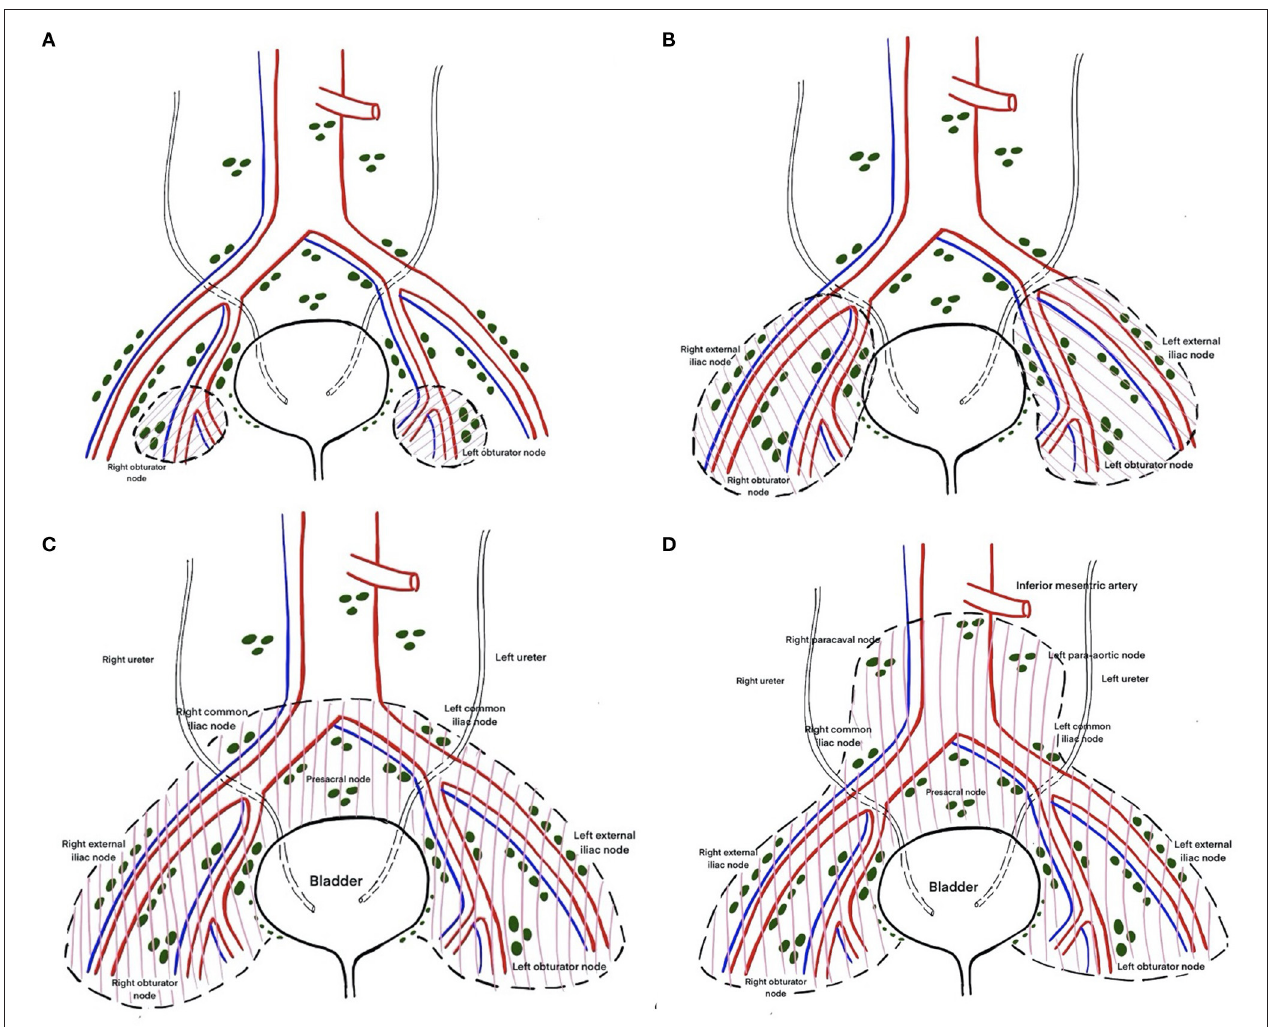
FIGURE 4 | (A) Limited lymph node dissection including only bilateral obturator and perivesical lymph nodes. (B) Standard template of lymph node dissection including lymph nodes of the external and internal iliac groups, up to bifurcation of the common iliac artery. (C) Extended template of lymph node dissection including lymph nodes up to the aortic bifurcation. (D) Super extended lymph node dissection including lymph nodes above the aortic bifurcation below the origin of the inferior mesenteric